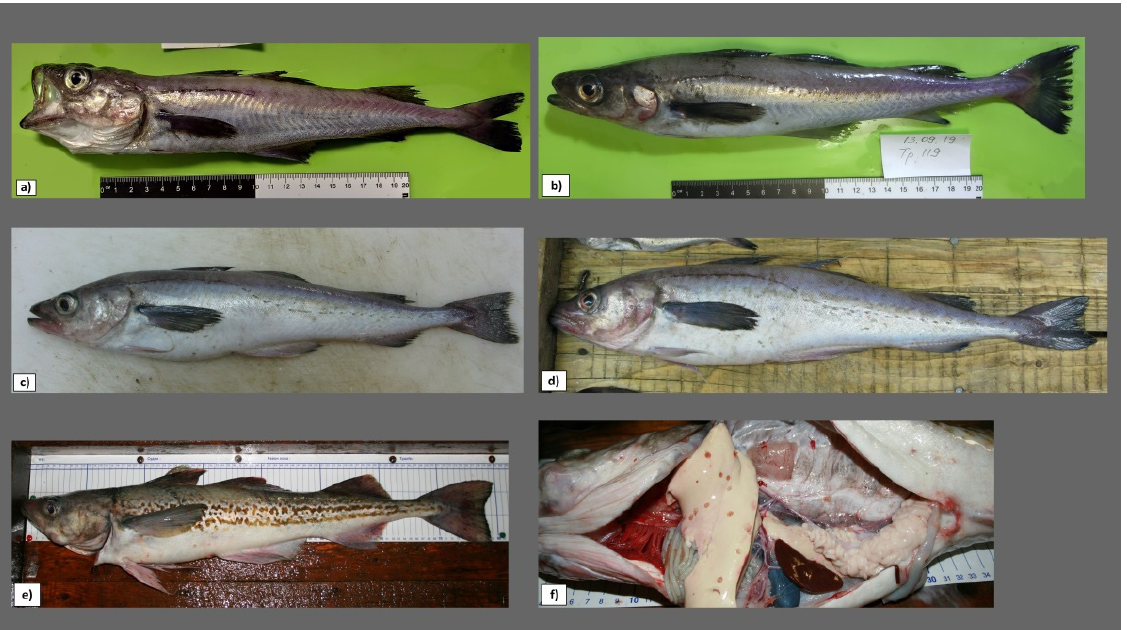
Figure 2. Photographs of walleye pollock Gadus chalcogrammus caught outside of native range (from the Laptev Sea ( a , b ), the Kara Sea ( c , d ), the Barents Sea ( e )) and viscera of specimen from the Barents Sea ( f ).